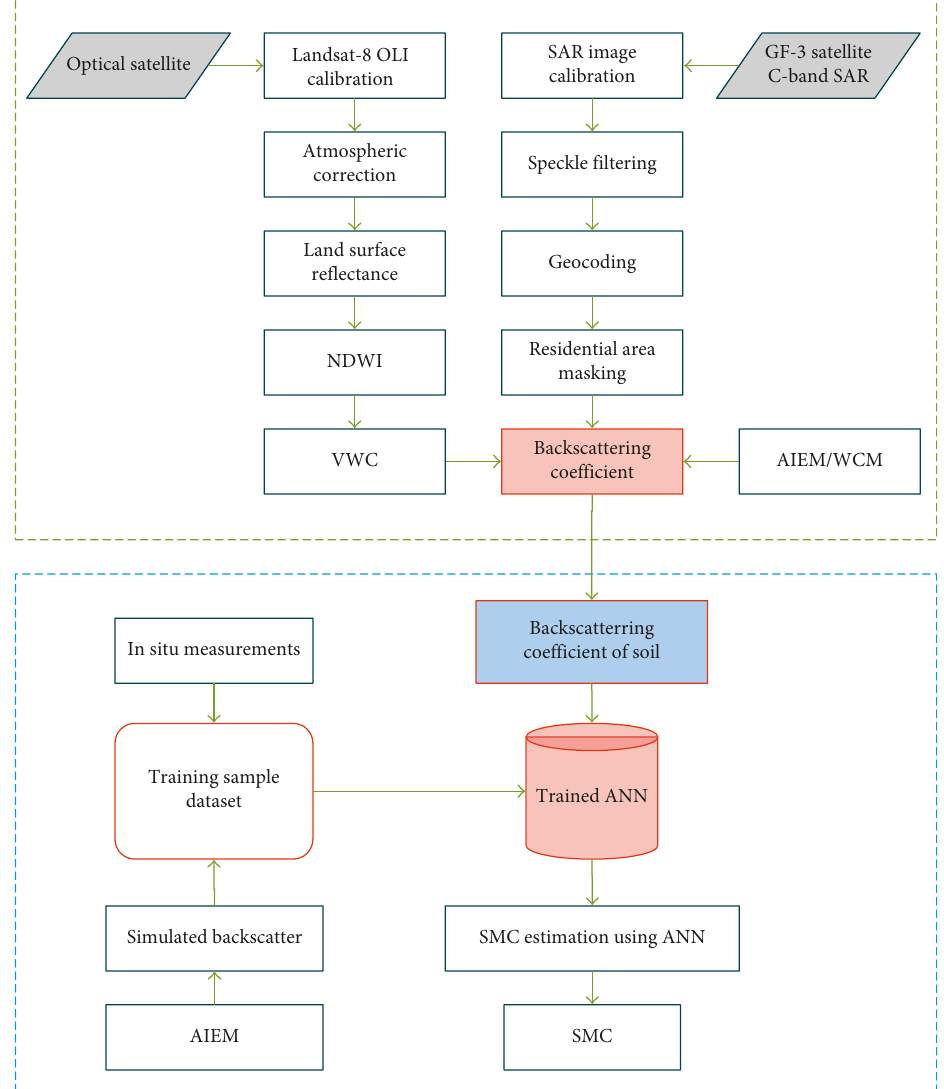
Figure 2: Flow chart for soil moisture content (SMC) estimation using an artificial neural network